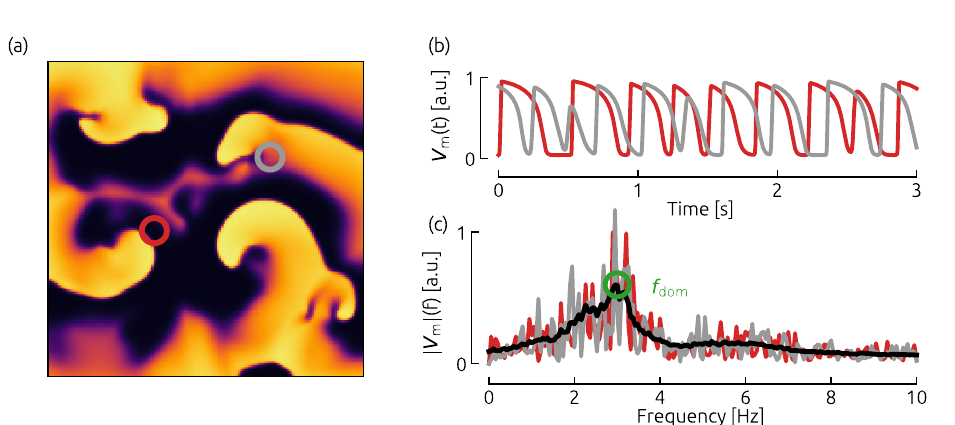
Figure 6. Determination of the dominant frequency f dom of the system. The time series of the membrane potential was sampled for each cell model (a representative snapshot is shown in ( a ) for the FK model). The red and gray circles indicate two exemplary locations, where a fraction of the time series is shown in subplot ( b ). Based on these time series, Fourier spectra were computed (shown in subplot ( c )), which were averaged in the end (black curve in ( c )). Note, that in practice, this procedure was performed not just for two locations, but for all pixels of the spatial domain. Also, the temporal length of time series which were used for the computation of the Fourier amplitude spectra, was 20s for all cell